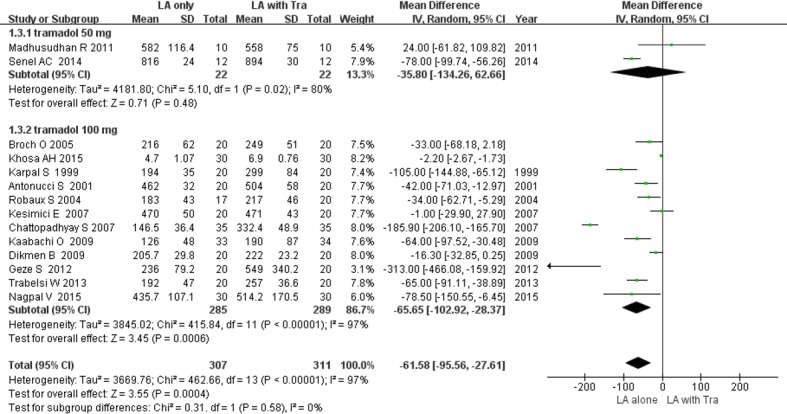
Forest plot demonstrating the duration of sensory block.Subgroup analysis according to dose of tramadol. CI, confidence interval; LA, local anesthesia; SD, standard deviation; Tra, tramadol.